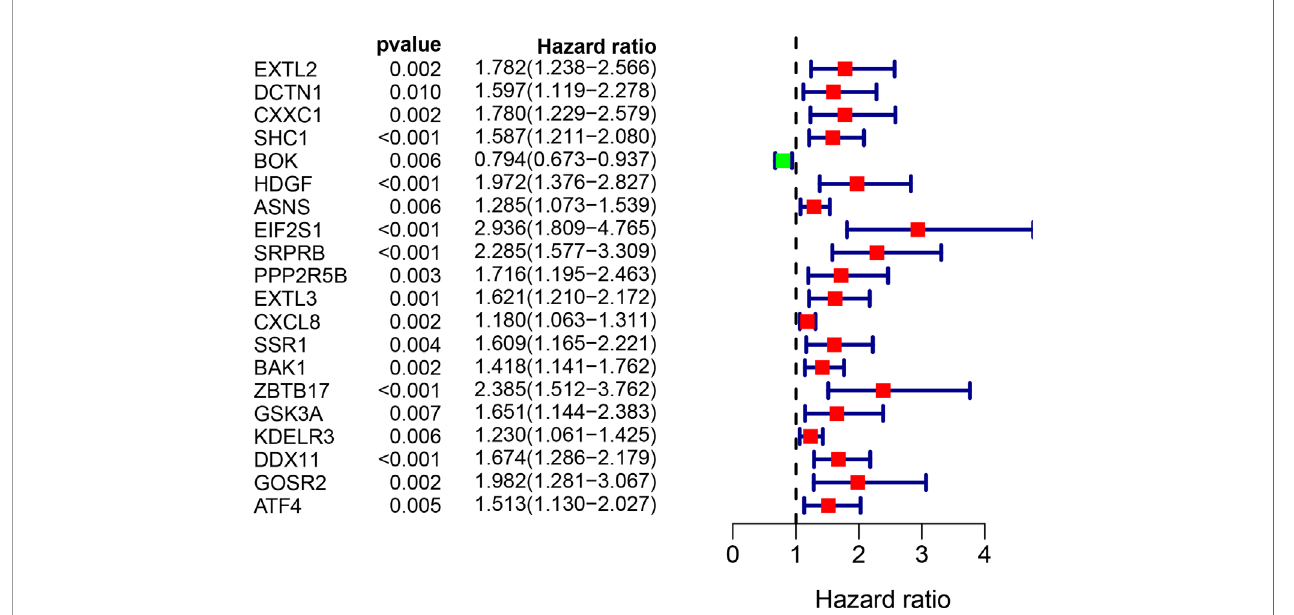
FIGURE 1 | Univariate Cox regression analysis of 20 genes related to ERS in the training set of TCGA cohort.